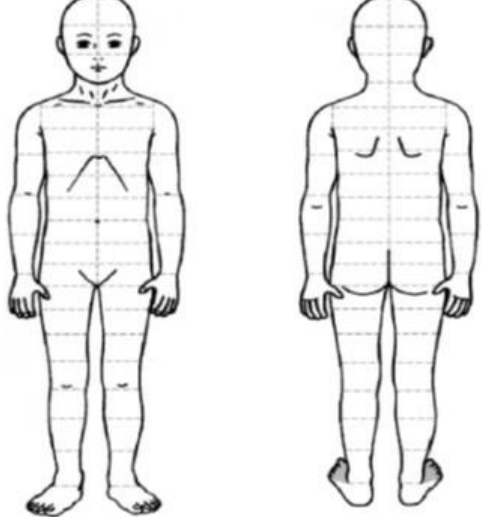
Figure 2. Form to calculate the percentage of body surface area (BSA) with skin lesions.